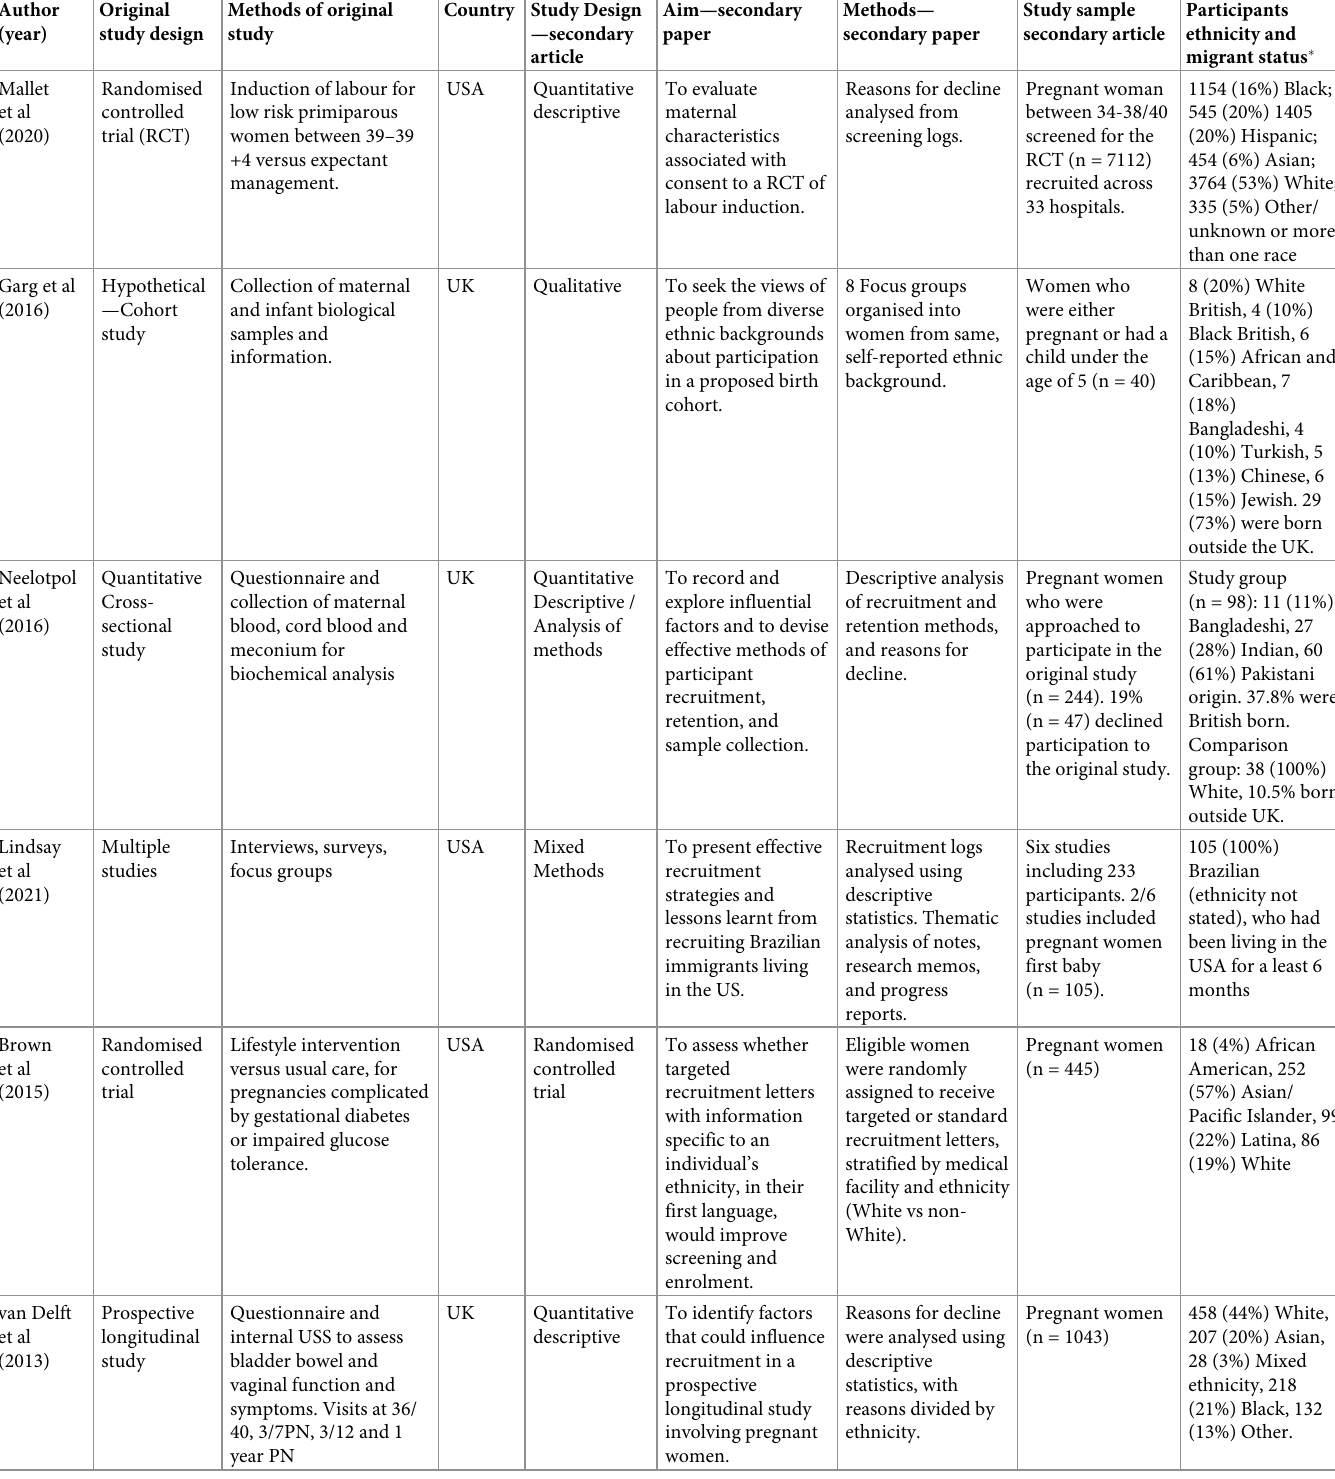
Table 3. Summary of study